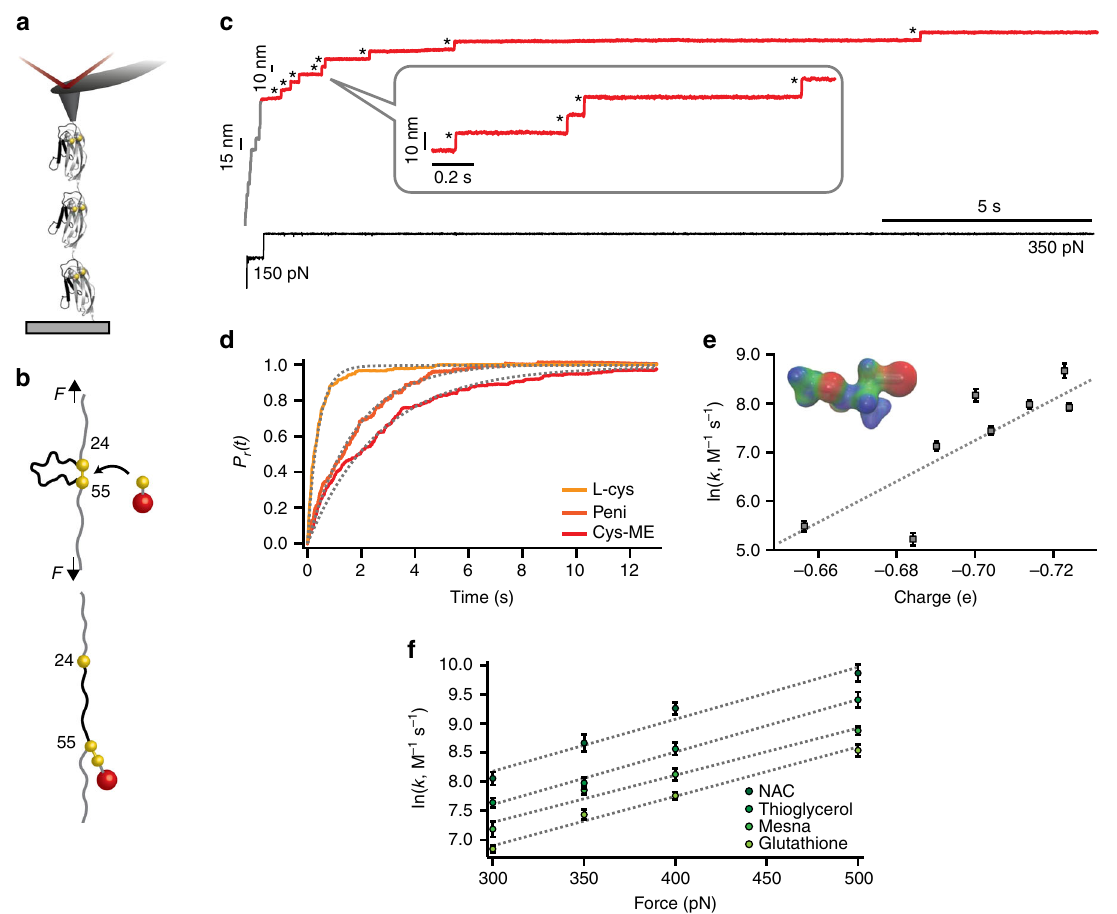
Fig. 2 Mechanical force can induce thermodynamically non-spontaneous disul fi de bond cleavage. a Schematic of the single-molecule force-clamp experiment, whereby a single (I27 E24C-K55C ) 8 polyprotein is stretched by an AFM cantilever. b In the mechanochemical assay, mechanical force unfolds the protein (gray region) up to the mechanically rigid disul fi de bond (formed between cysteine 24 and 55), which becomes solvent exposed. The presence of a nucleophile triggers disul fi de cleavage, fi ngerprinted by the 10 nm steps that correspond to the extension of the protein amino acids that were trapped behind the disul fi de bond (red region). The resulting reduced and mechanically unfolded protein harbors a mixed disul fi de and a reduced protein thiolate. c Individual reduction trajectory demonstrating that the protein disul fi de bond can be cleaved by 2 mM cysteine-methyl-ester (black asterisks mark the reduction of each individual disul fi de bond under force, fi ngerprinted by a stepwise increase in the protein length of ~10 nm). d Disul fi de bond rupture kinetics at F = 350 pN for the thermodynamically largely disfavored disul fi de bond reduction by Cys-ME (red) and the marginally un-favored reaction in the presence of penicillamine (dark orange), compared to that of L-cysteine (orange). All compounds were kept at a constant deprotonated concentration [S − ] = 2 mM. e The concentration-normalized rate of rupture for all compounds at a constant F = 350 pN correlates with the electrostatic partial charge localized on the nucleophilic sulfur. (Inset: charge distribution plot of Cys-ME, from red (negative), to green (~0) to blue (positive)) (From left to right n = 13, 24, 23, 17, 35, 23, 34, and 17, where n = number of individual trajectories). f The force-dependent reduction kinetics for NAC, thioglycerol, mesna,